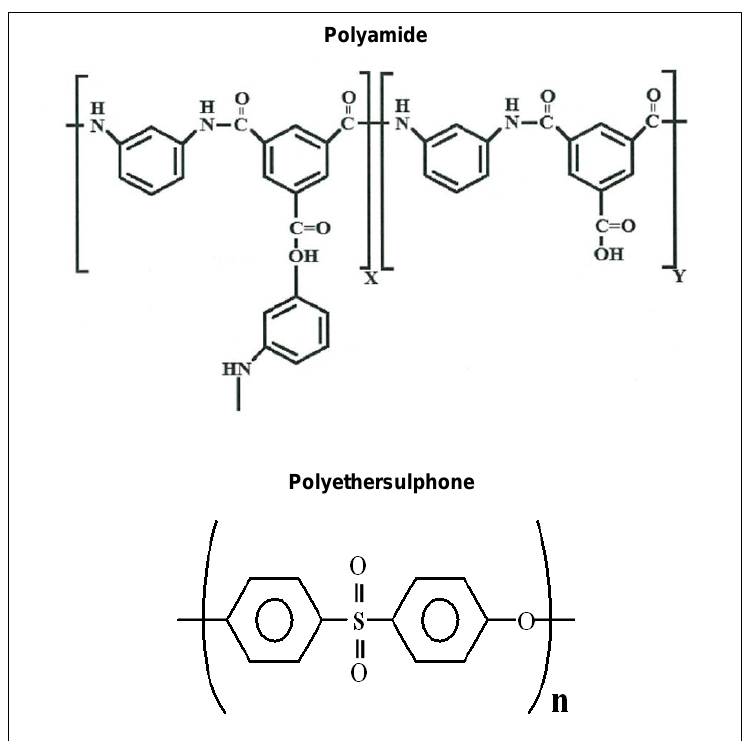
Figure 12. Chemical structure of the polymers. 377